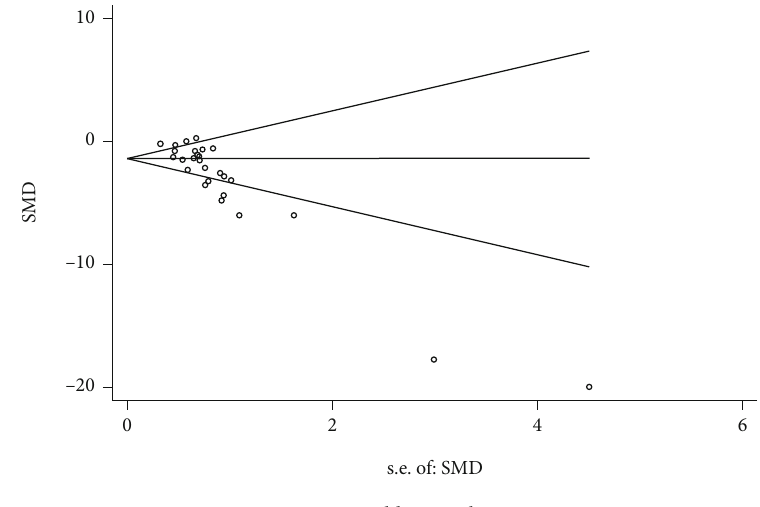
Figure 5: Publication